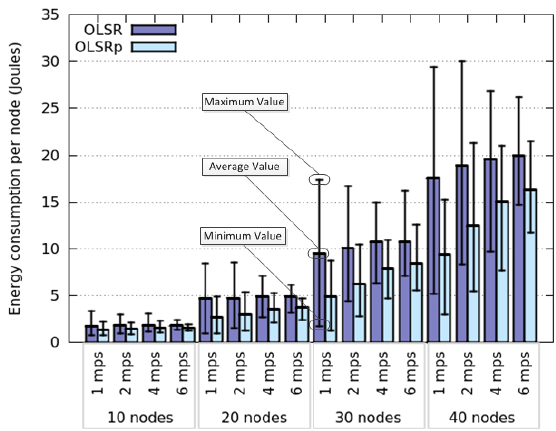
Figure 4. Energy consumption when nodes follow a Random Walk model.